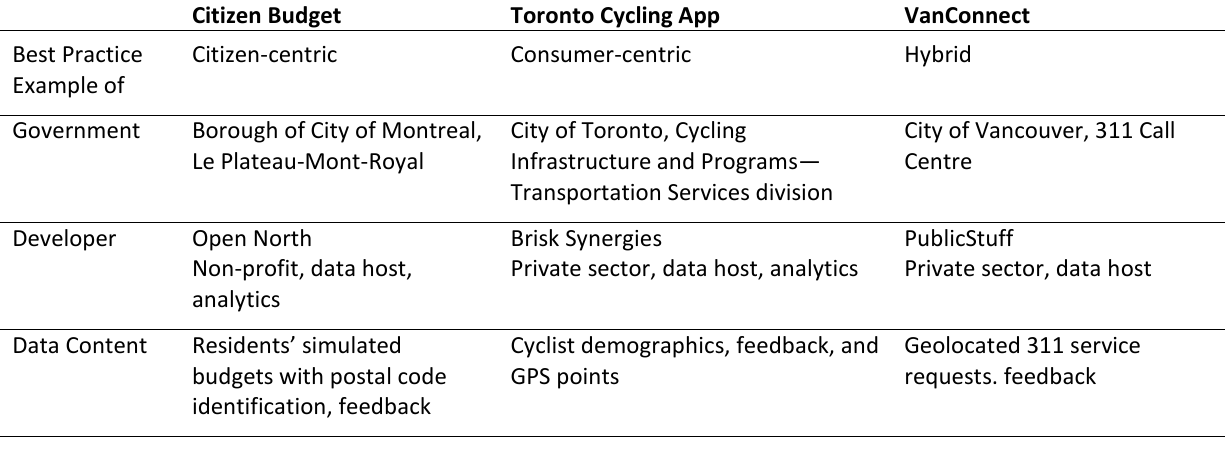
Table 2. Overview of